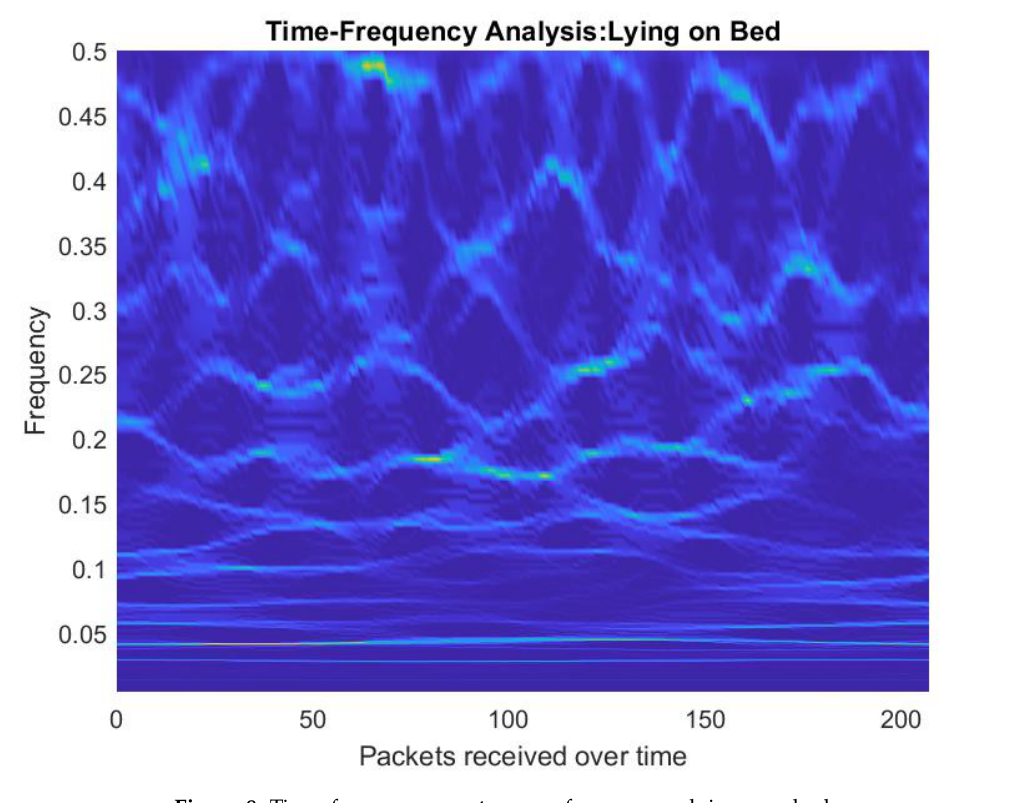
Figure 8. Time–frequency spectrogram for a person lying on a bed.